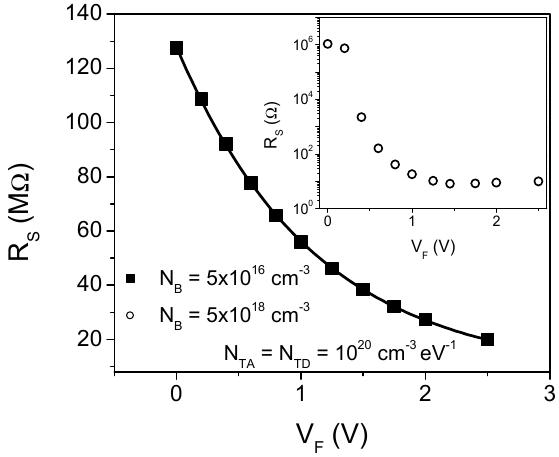
Figure 8. Calculated series resistance vs. forward bias, for N B of 5 × 10 16 cm − 3 . In the inset, the corresponding plot for N B of 5 × 10 18 cm − 3 is shown.